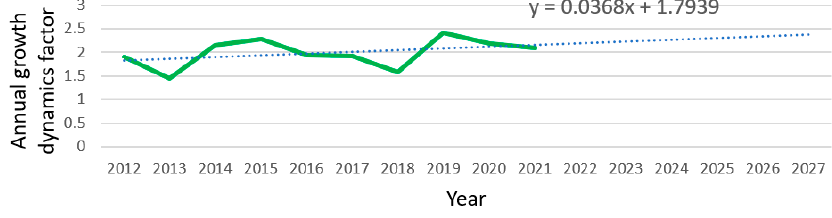
Figure 6. Variability of annual growth rates.